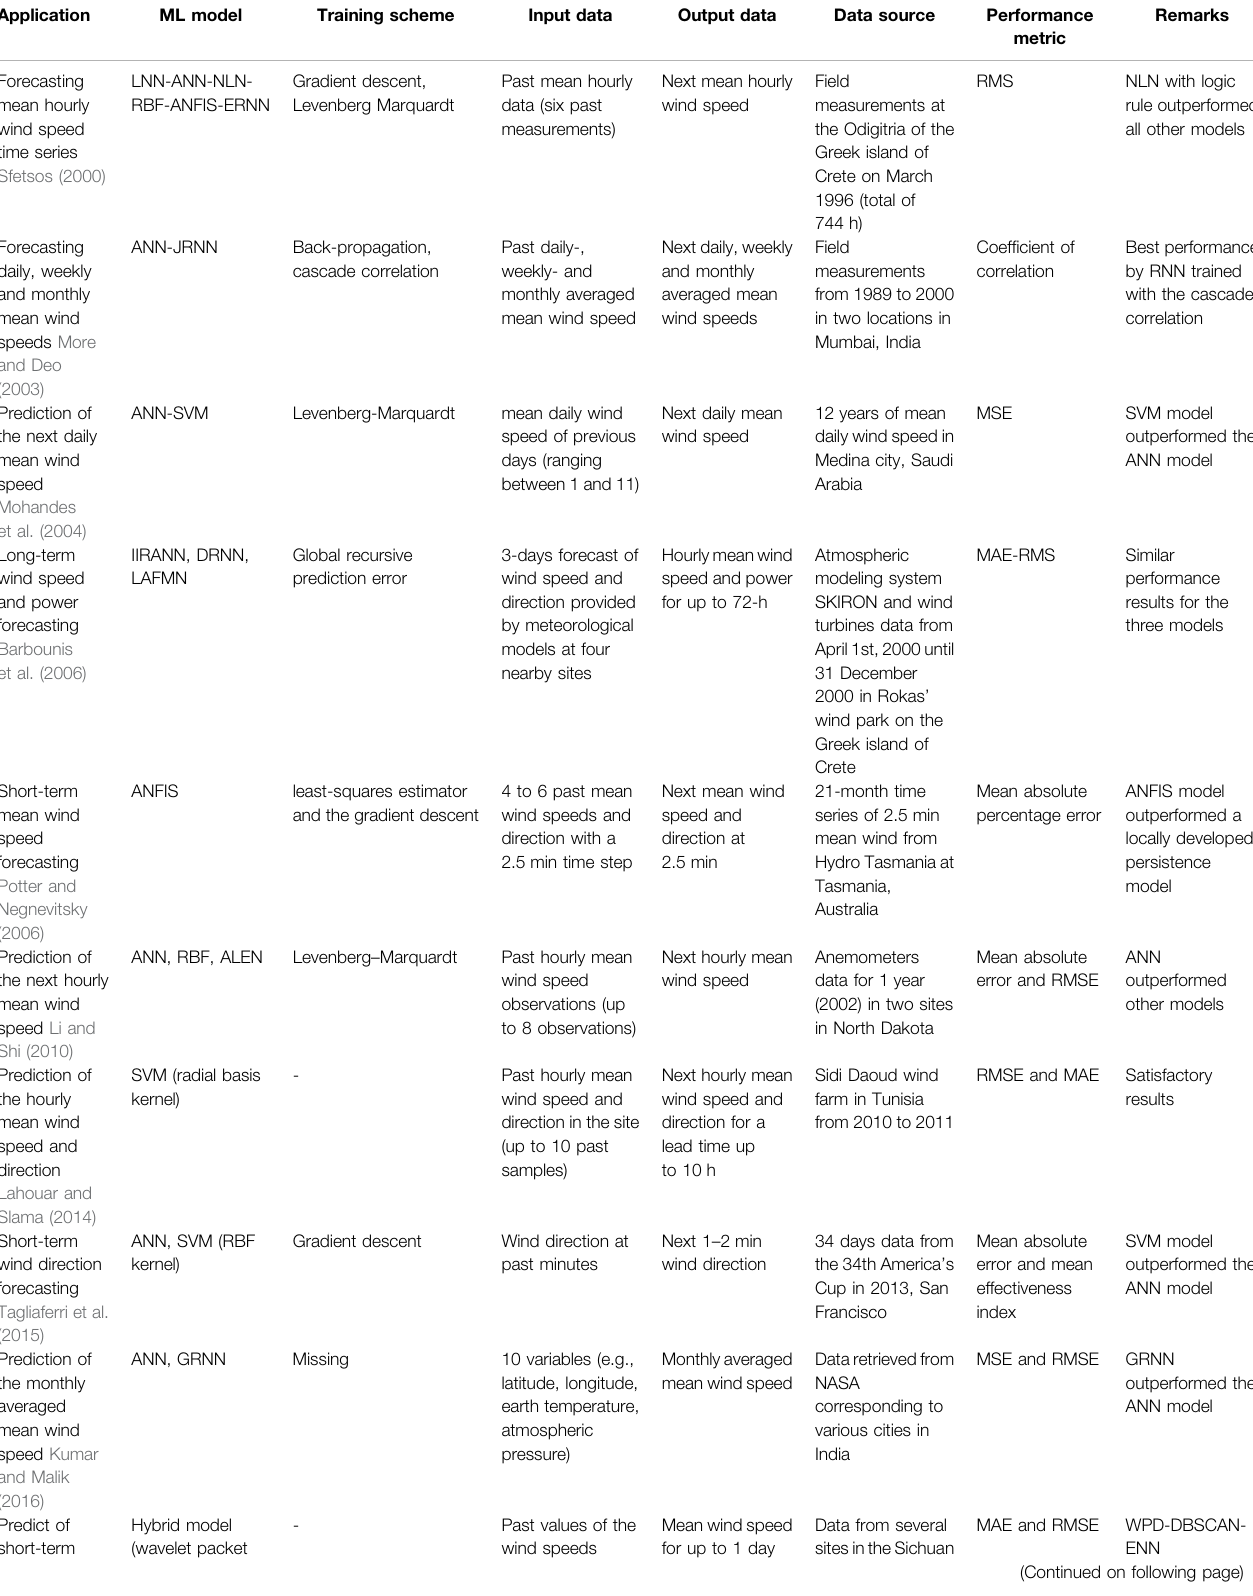
TABLE 1 | Summary of ML applications for classical boundary-layer